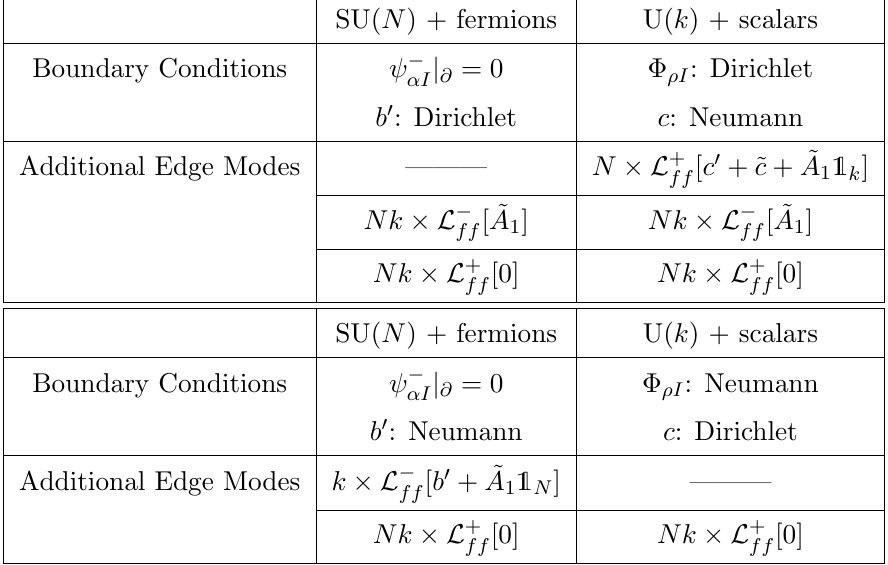
Table 2 . The top (bottom) table counts the additional edge modes when choosing Neumann and Dirichlet boundary conditions on the dynamical gauge (cid:12)elds in U (SU) and SU (U) side respectively when N s =